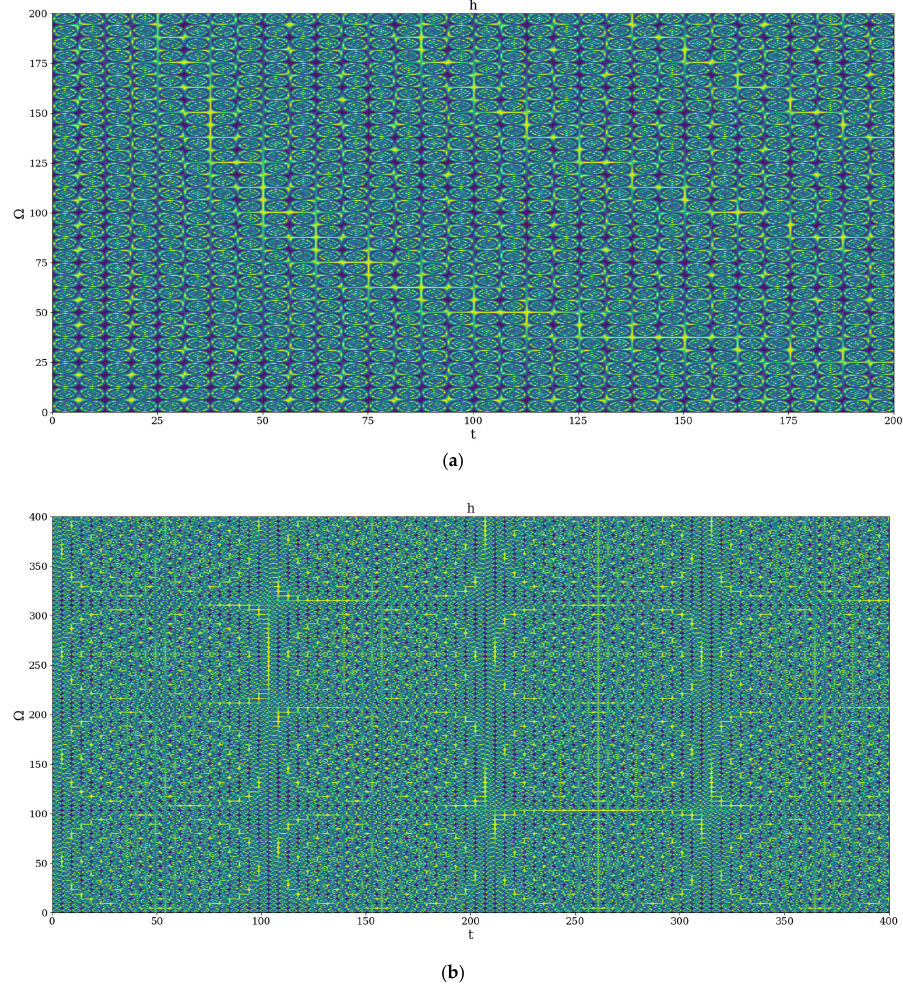
Figure 1. 2D dynamics at global scale resolution plot of |ℎ| from (31) for 𝜒 = 2.35 and ( a ) 𝛺 = 0 −200,𝑡 = 0 −200 , ( b ) 𝛺 = 0− 400,𝑡 = 0−